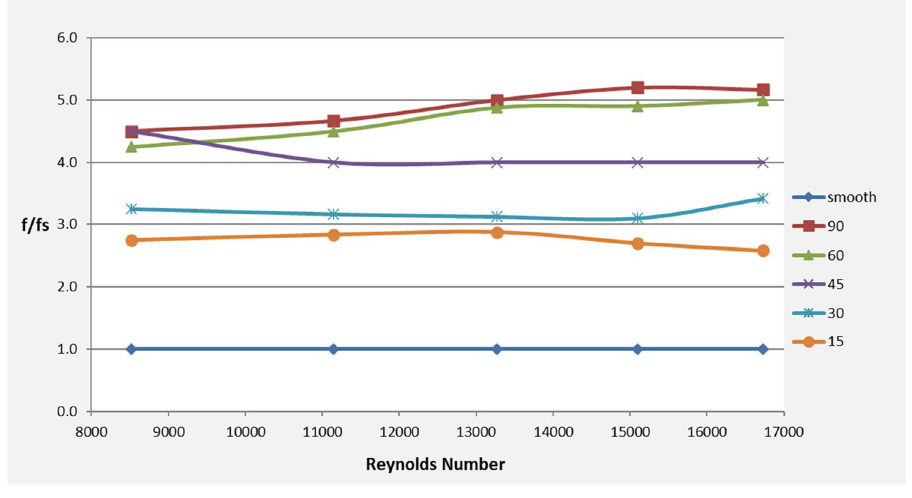
Fig. 10 Variation of f/fs with Reynolds Number at P/D = 6